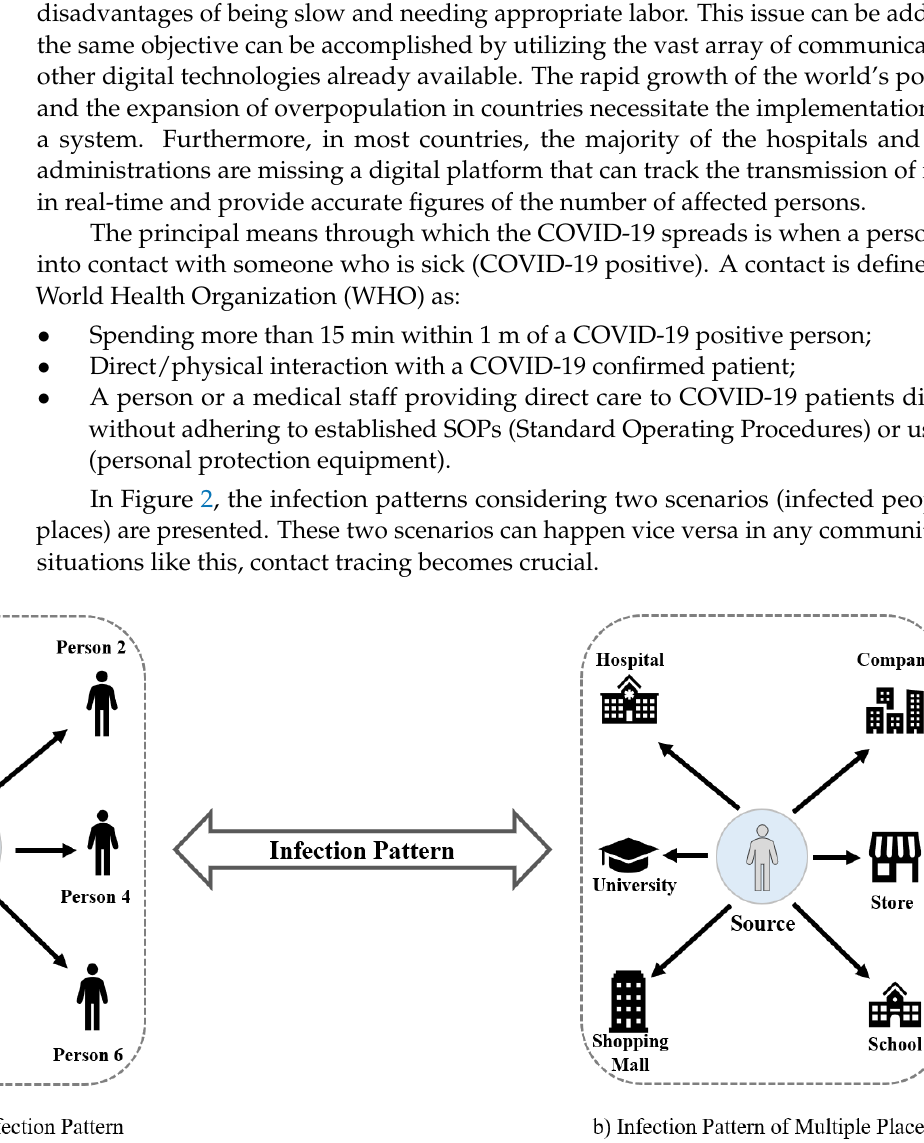
Figure 2. Representation of infection patterns: ( a ) infected persons and ( b ) infected places.